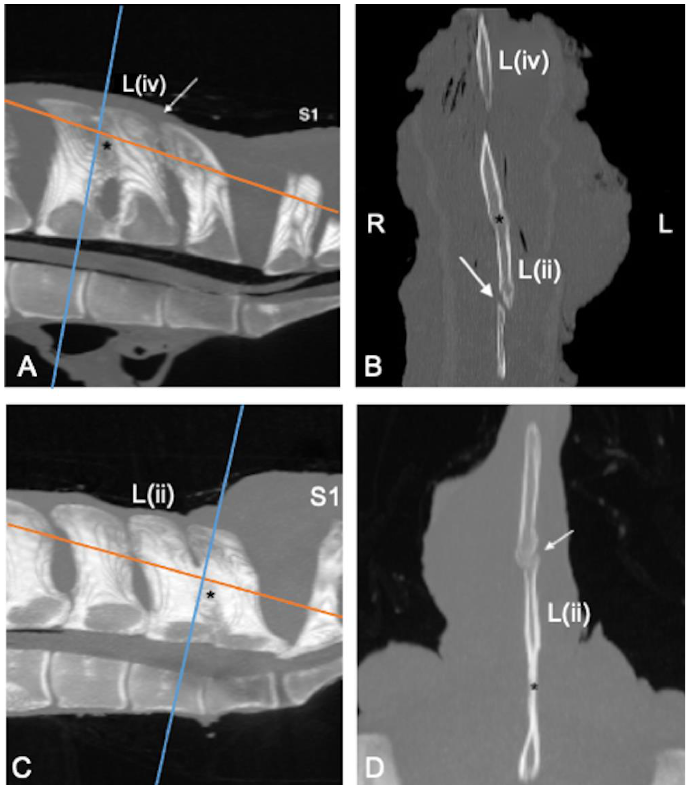
Figure 2. Sagittal ( A , C ); cranial is toward the left and dorsal ( B , D ); cranial is toward the top multi- planar reconstruction computed tomographic images of the lumbosacral specimens 8 and 25, using maximum intensity projection (MIP). ( A , B ) Complete obliteration of the L(iii)-L(ii) interspinous space due to fusion of the dorsal and middle portion of the respective spinous processes (SPs) (asterisk) and severe narrowing of the L(ii)-L(i) interspinous space (arrow). ( C , D ) Fusion of the middle and